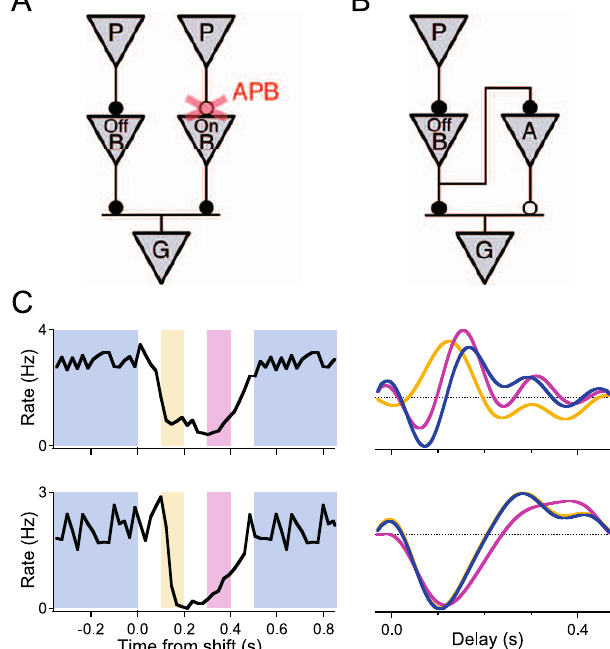
Figure 3. A Polarity-Reversing Ganglion Cell Receives On Inputs from the On Bipolar Pathway (A and B) Two possible circuits underlying On-type responses of ganglion cell, involving photoreceptors (P), bipolar cells (B), amacrine cells (A), and ganglion cells (G), linked by excitatory (closed circles) or inhibitory (open circles) synapses. (A) The ganglion cell is excited by both On-type and Off-type bipolar cells. Application of 2-amino-4-phosphono-butyrate (APB) blocks the On pathway at the photoreceptor synapse. (B) The ganglion cell is excited by Off bipolars, and also inhibited by Off amacrine cells. This On pathway is not affected by APB. (C) Application of APB abolishes polarity reversal. Top: modulation of the firing rate and the linear filter by the peripheral shift, displayed as in Figure 2C for a sample ganglion cell. Bottom: same as top panel, after application of 150 l M APB.